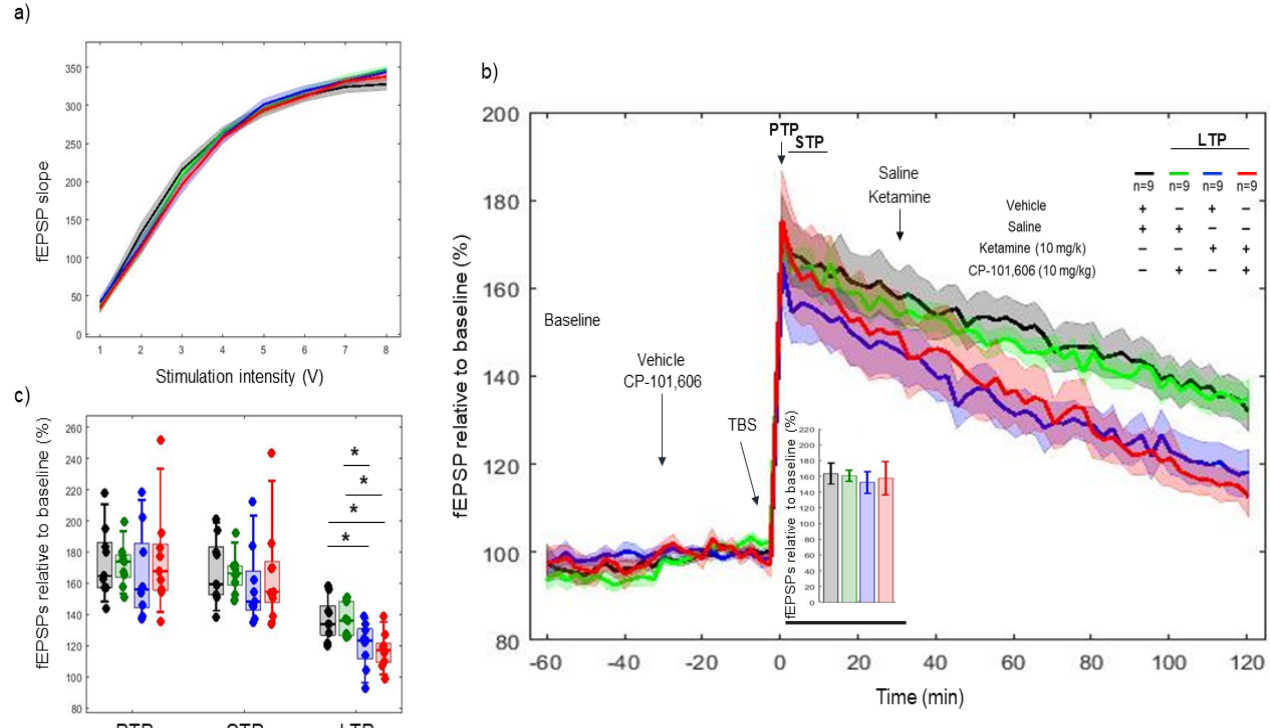
Figure 5. LTP response to a combined pharmacology of CP-101606 (10 mg/kg) and ketamine (10 mg/kg) reduced the TBS-induced LTP response. ( a ) Collective input/output curves of stimulation voltage and fEPSP slope overlap and no difference was observed in basal synaptic excitability prior to treatment with CP-101606 (vehicle) and ketamine (saline). ( b ) Basal fEPSPs before tetanization were considered indifferent while after tetanization, the LTP responses of CP-101,606–ketamine (red, n = 9) and vehicle–ketamine treated animals (blue, n = 9) were lower than the LTP responses in the CP-101,606–saline (green, n = 9) and vehicle–saline (black n = 9) groups. Values represent mean ± 95% confidence intervals. ( c ) PTP, STP and LTP responses boxplots, * p < 0.05.